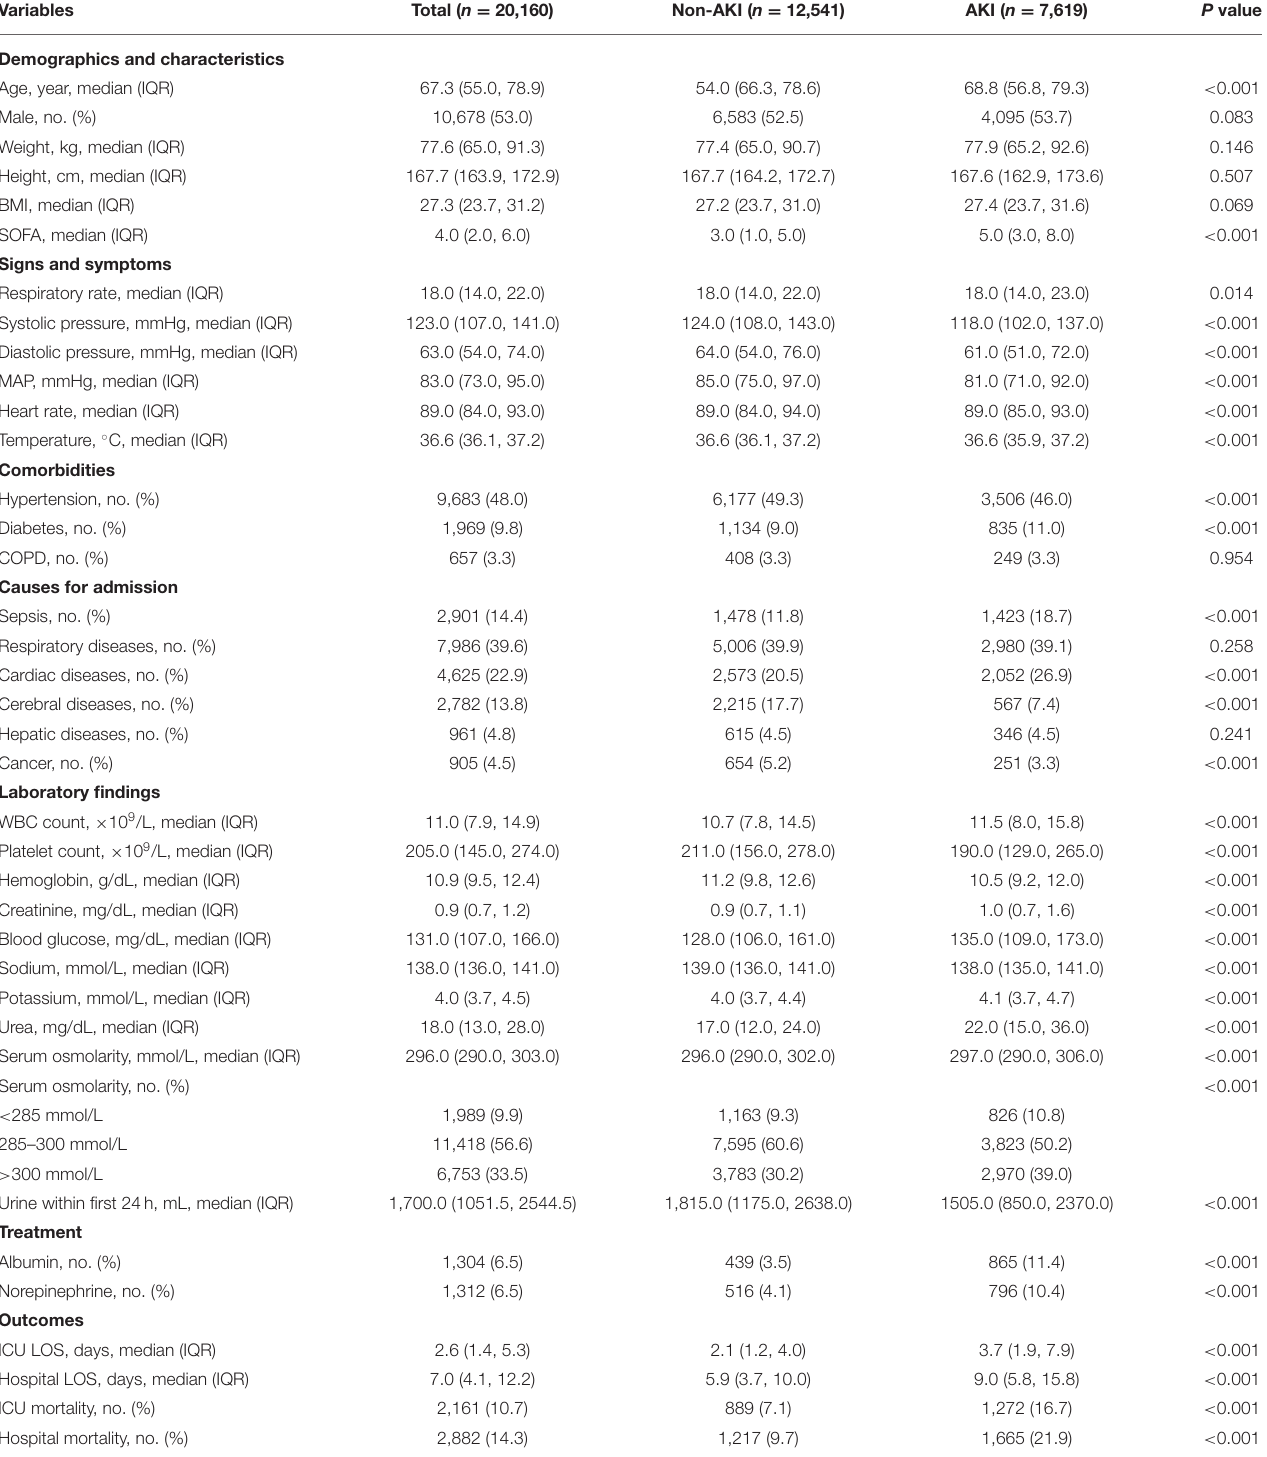
TABLE 1 | Comparisons of demographics between non-AKI and